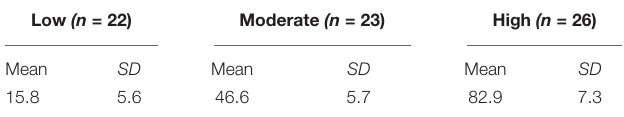
TABLE 4 | Percentile scores of working memory capacity measured by